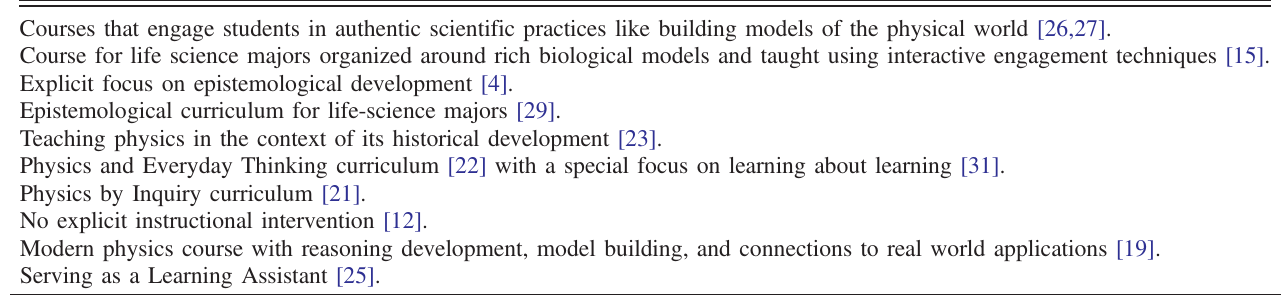
TABLE VI. Teaching methods associated with positive shifts on the CLASS or MPEX as documented in the